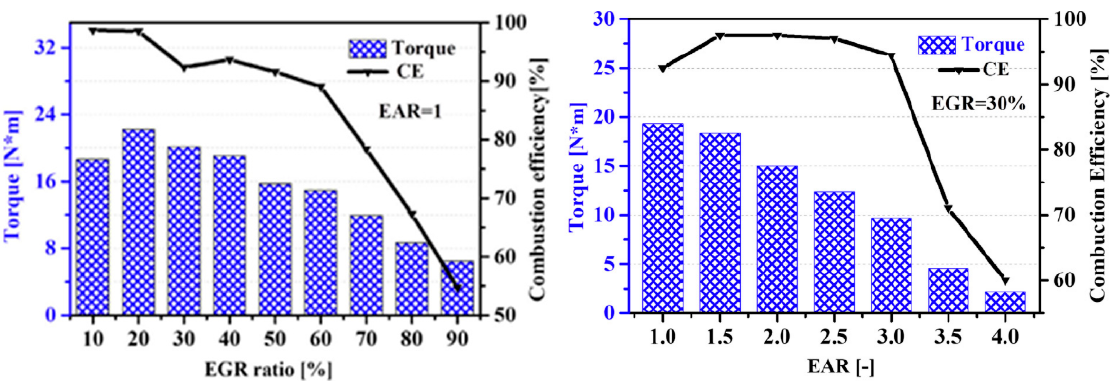
Figure 8. Combustion efficiency and torque at different EGR rates and excess air ratios [122].